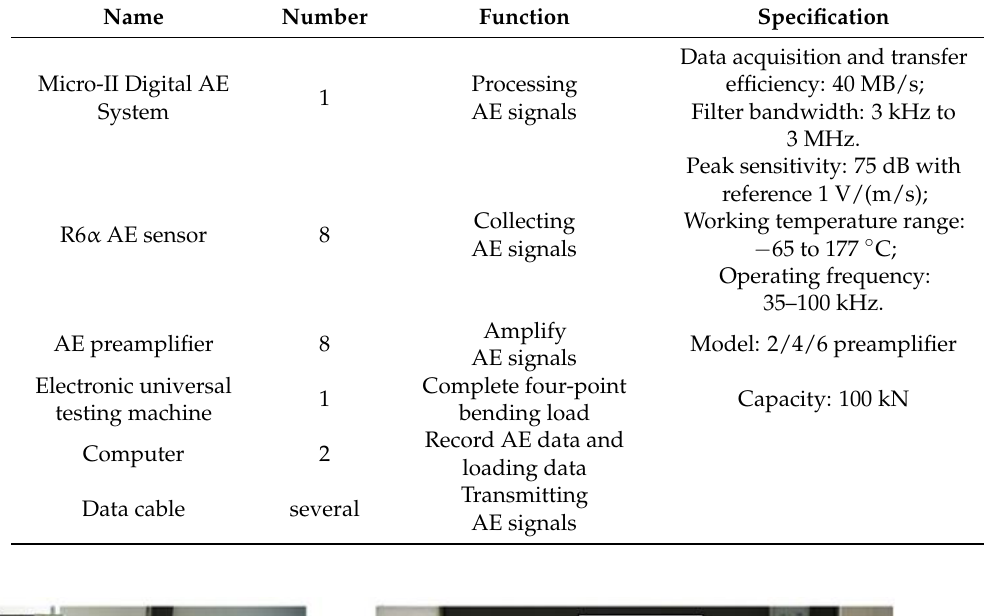
Table 2. Information on test apparatus.